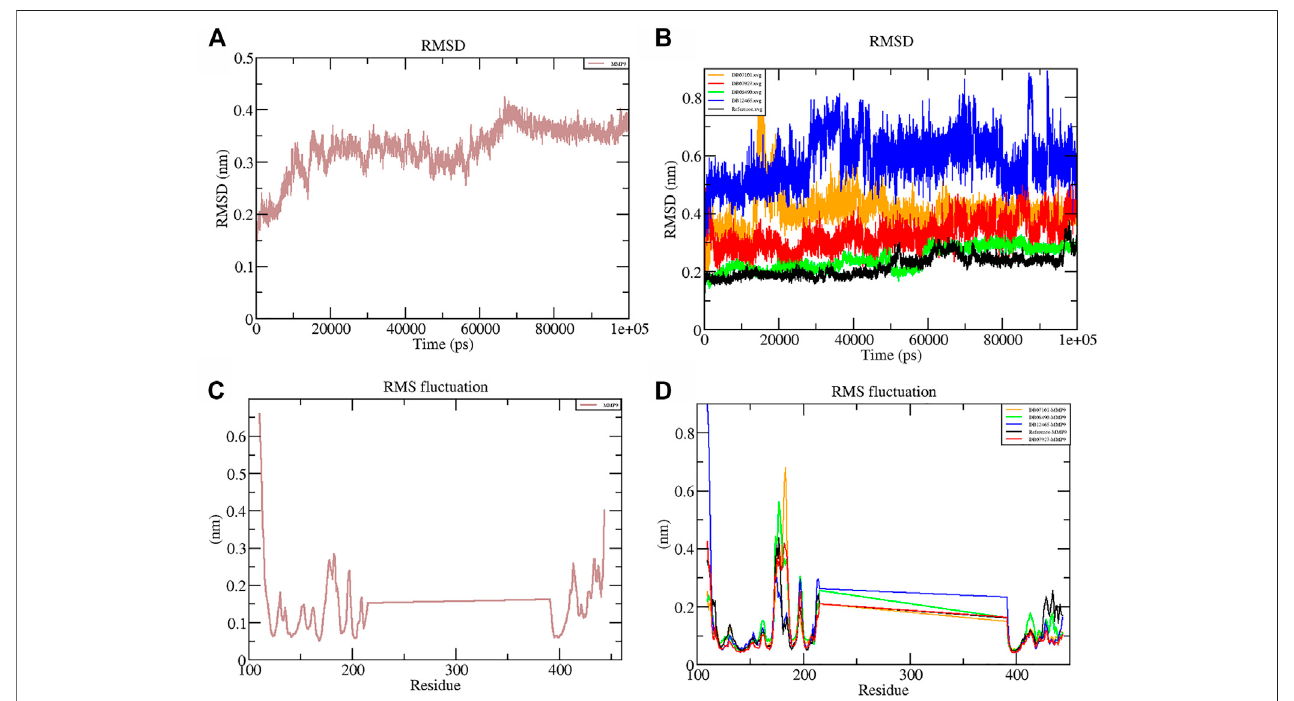
FIGURE 5 | Graphs representing the RMSD plot of protein MMP-9 (A) and MMP-9 – ligand complexes (B) ; RMSF plot of MMP-9 (C) and MMP-9 – ligand complexes (D)